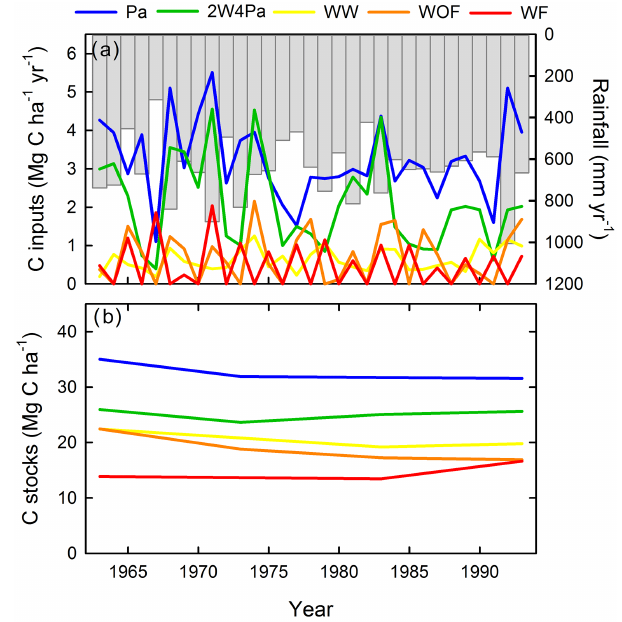
Figure 1. Annual precipitation and carbon inputs for the five crop- ping systems (a) , and measured soil organic carbon stocks to 10cm at the four sampling dates in these cropping systems (b) . Crop- ping systems are as follows: Pa, permanent pasture; 2W4Pa, 2 years of wheat followed by 4 years of pasture; WW, continuous wheat;